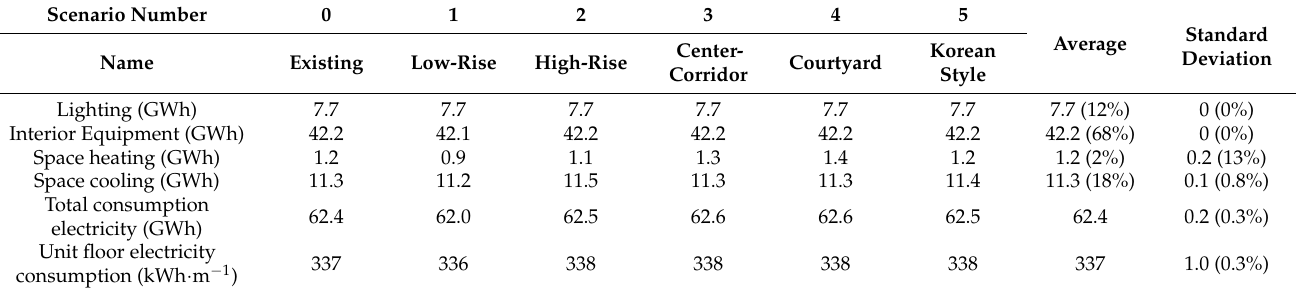
Table 3. Calculated building energy demands for the scenarios. Parentheses at average section represent percentages of demand components to the total demand. Parentheses at standard deviation section represent percentages of standard deviation divided by